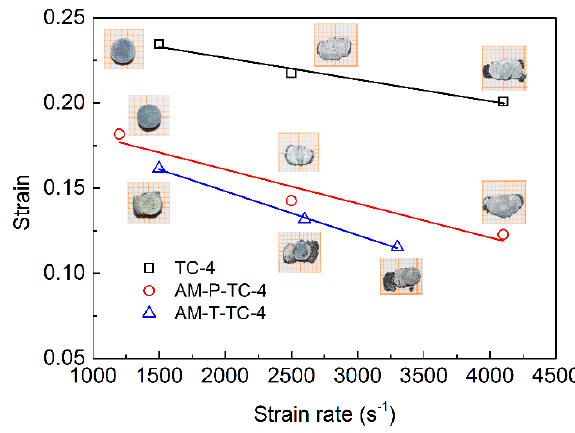
Figure 12. Effect of strain rate on material fracture behavior.